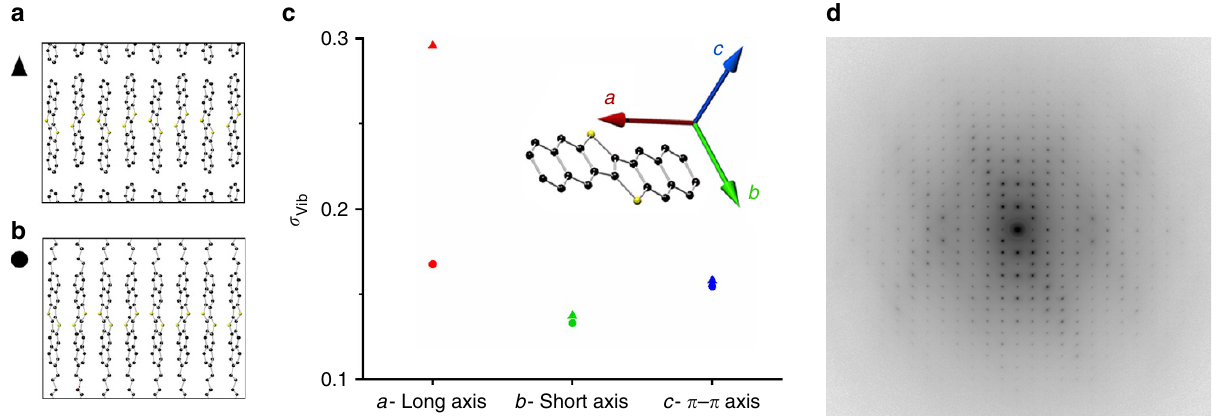
Figure 4 | Molecular vibrations in materials with a similar molecular design than C8-BTBT. Cross-sectional view of ( a ) DNTT and ( b ) C10-DNTT. ( c ) Thermal amplitudes as computed from MD simulations along different axis a , b and c for DNTT (triangles) and C10-DNTT (circles). ( d ) Experimental diffraction pattern of C10-DNTT at room temperature, showing only very weak diffuse characteristics similar to those in